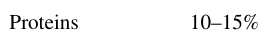
Table 3 The healthy ranges of nutrition components provided by WHO (https:// www. who. int/ health- topics/ nutri